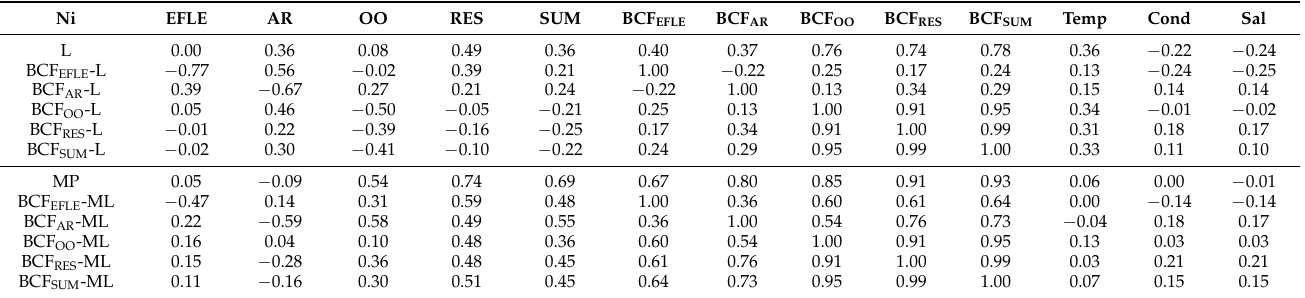
Table 10. Nickel correlation coefficients between variable A (Ni levels in the lamina (L), midrib plus petiole (MP), and Ni bioconcentration factors (BCF)) and variable B (geochemical fractions in the sediments and surface water parameters). Values in red are significant at p <